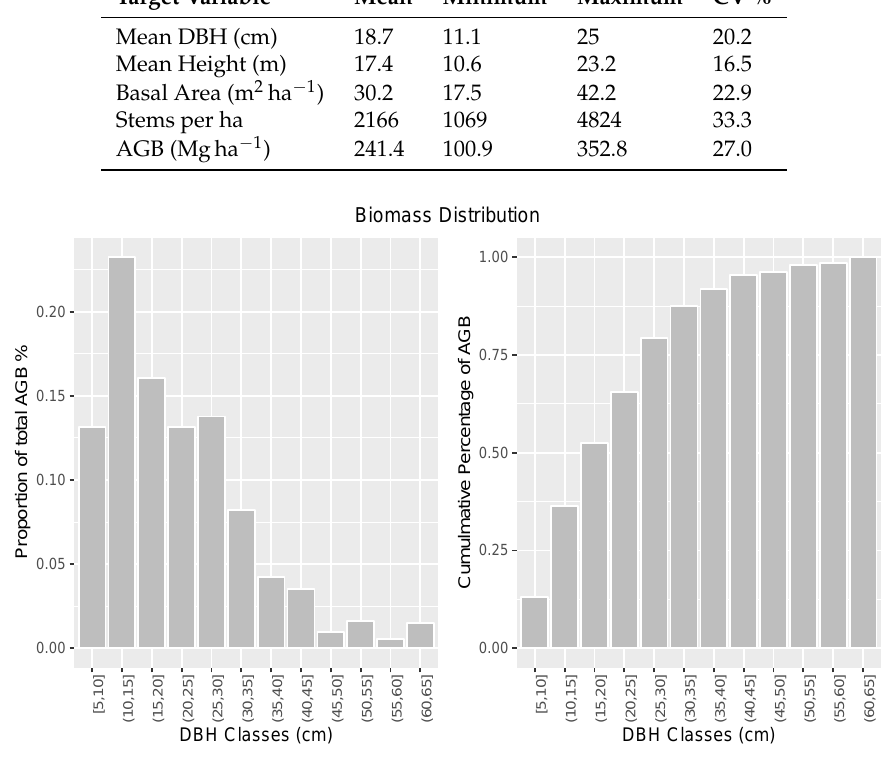
Figure 4. Distribution of the total biomass over 5cm diameter classes for the HIL